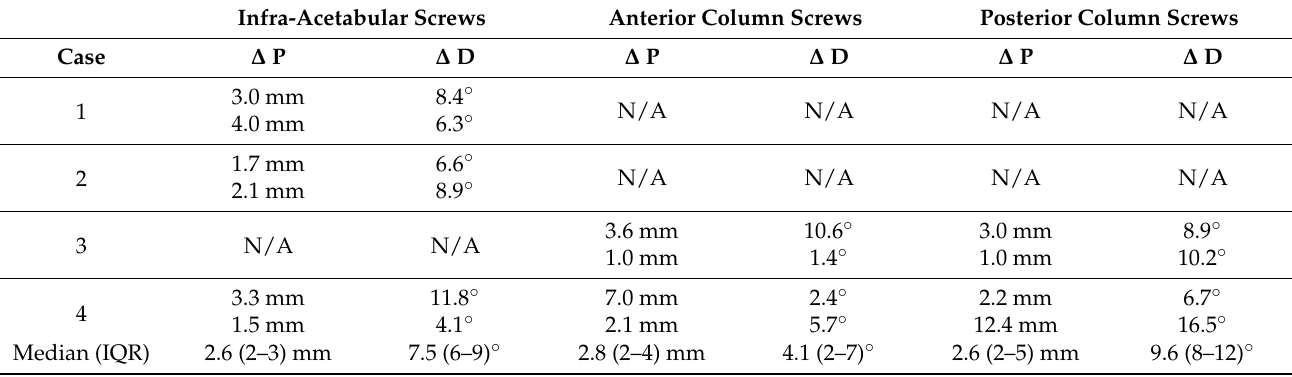
Table 2. Column and infra-acetabular screw difference. The difference in entry point ( ∆ P) and direction ( ∆ D) of the infra-acetabular, anterior column, and posterior column screws between the preoperative and postoperative 3D model for each case. Finally, the median differences with the interquartile range (IQR) are presented for each type of